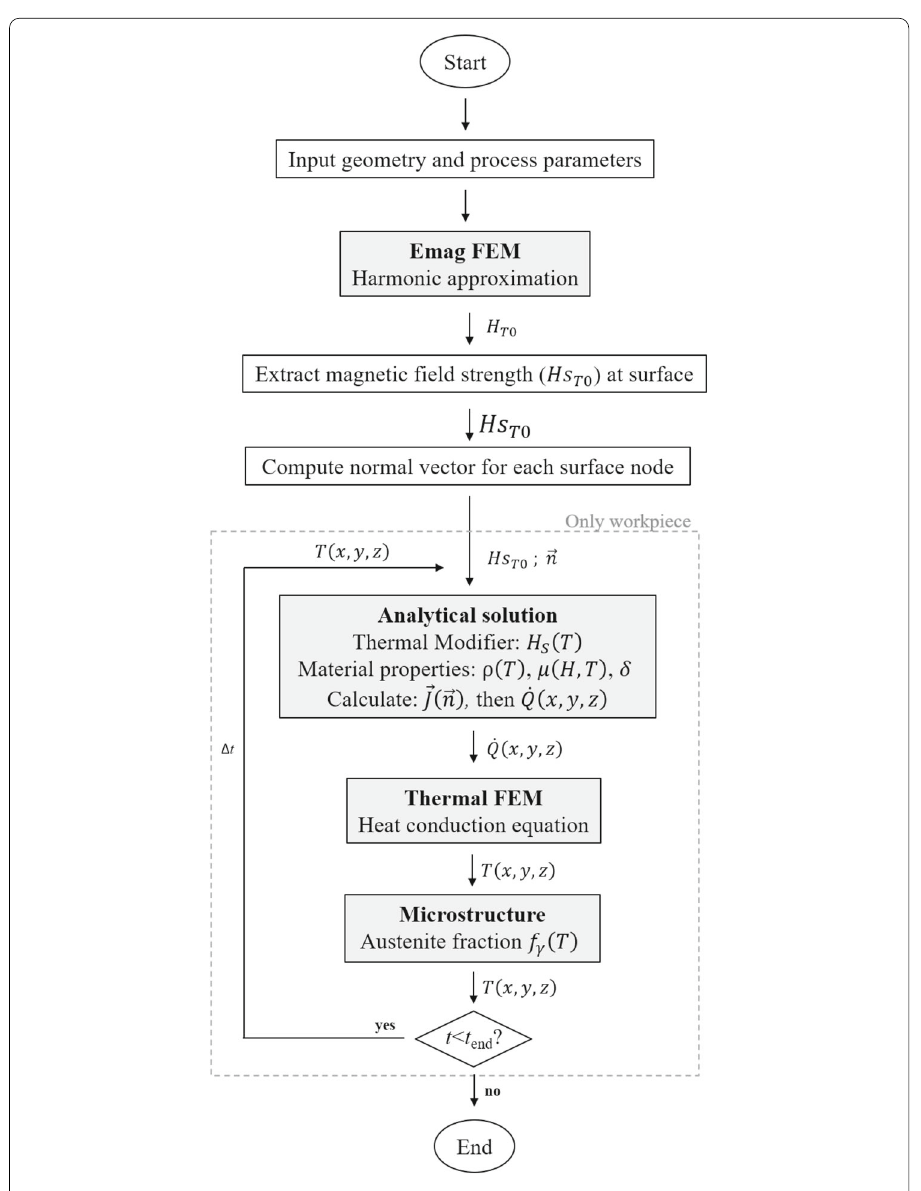
Fig. 4 Flowchart of the proposed methodology